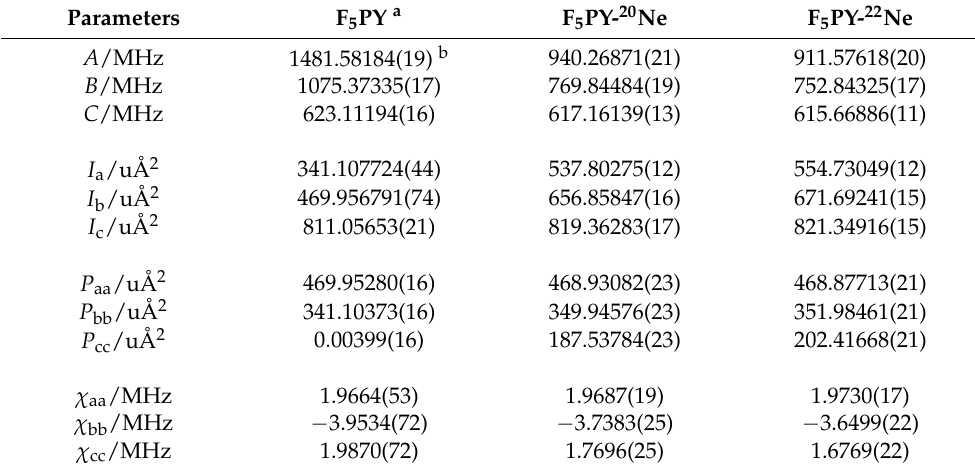
Table 2. Comparison of the rotational constants ( A , B , C ), the moments of inertia ( I a , I b , I c ), and the planar moments ( P aa , P bb , P cc ) of F 5 PY and F 5